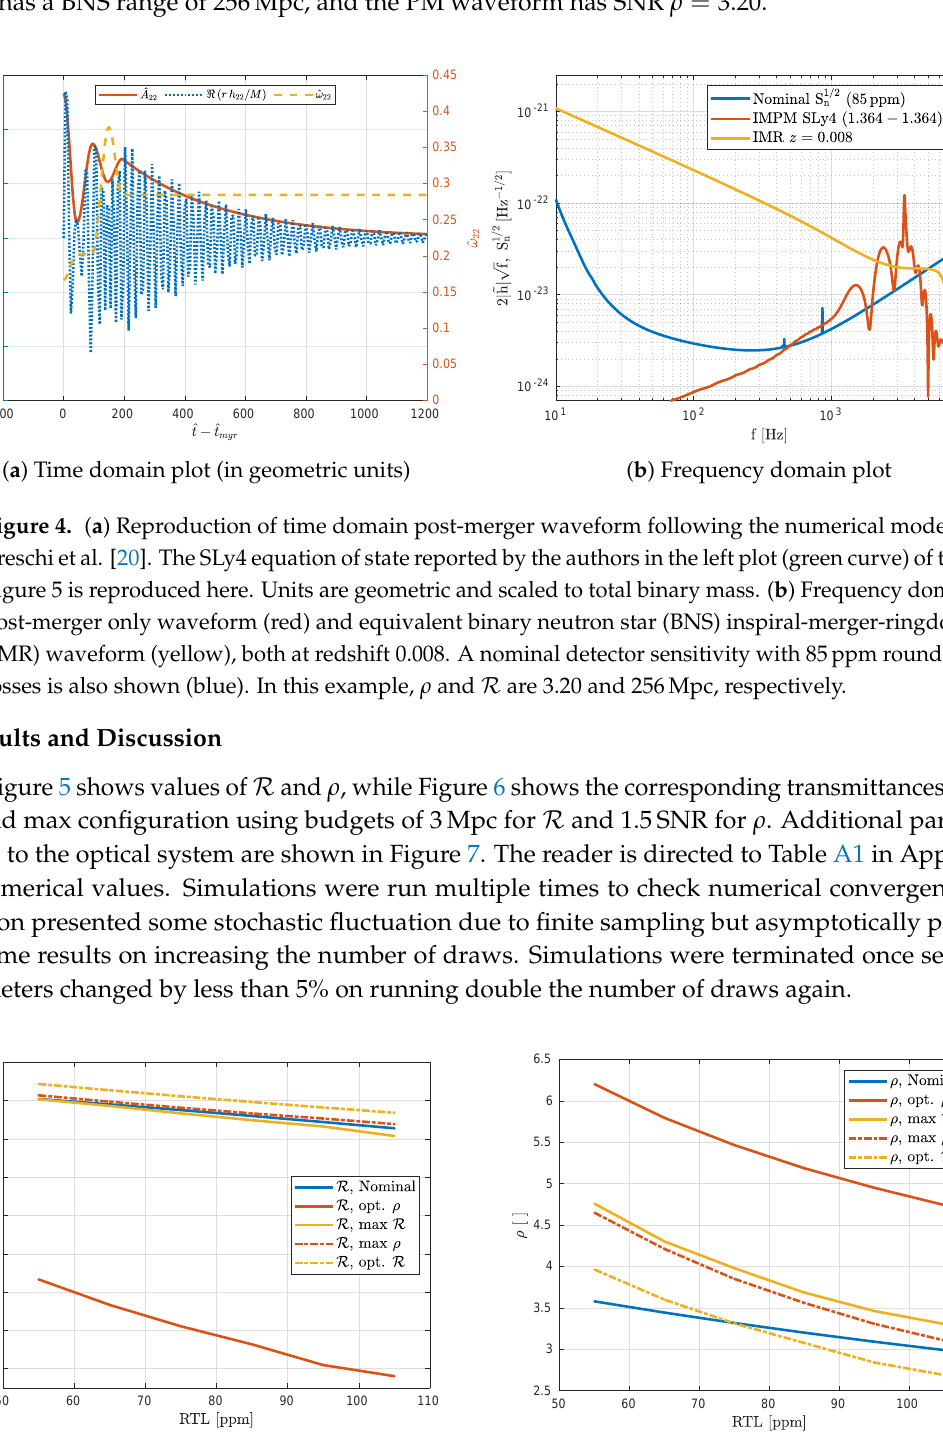
(yellow), and the nominal sensitivity curve (blue). In this example, the O5 low nominal sensitivity curve has a BNS range of 256 Mpc, and the PM waveform has SNR ρ = 3.20.